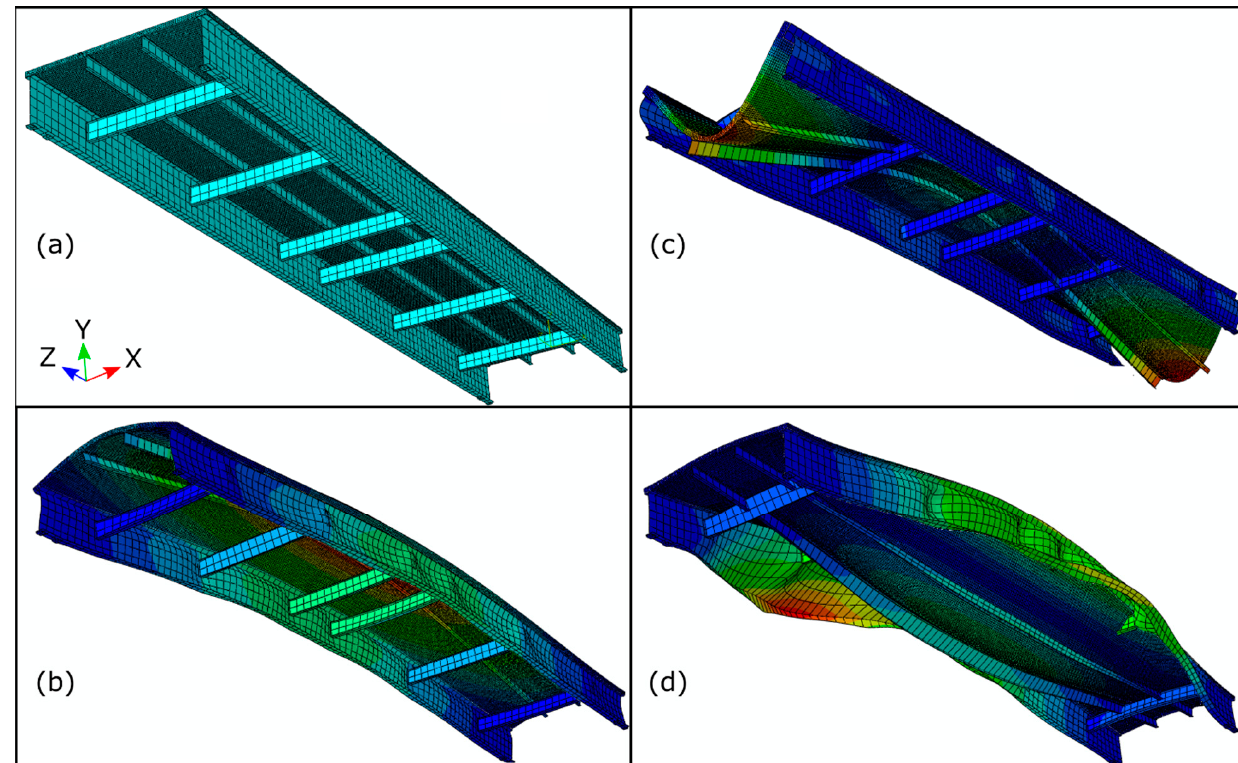
Figure 5. FEM of the full-scale bridge and its dominant modes in the dry condition: ( a ) undeformed FEM; ( b ) 1st mode shape; ( c ) 4th mode shape; ( d ) 9th mode shape. The model is colored by normalized displacement magnitude.